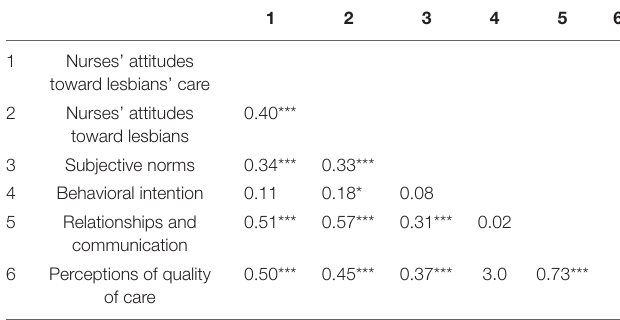
TABLE 4 | Pearson correlation coefficient between study variables ( N =